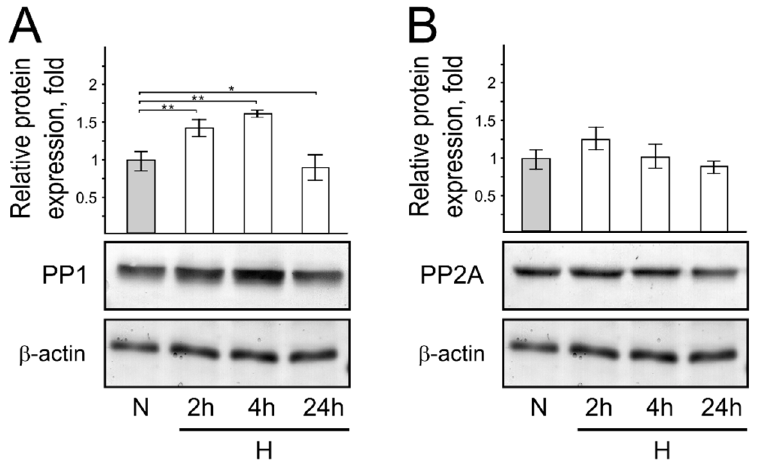
Figure 6. Protein phosphatase PP1 and PP2A protein expression in normoxic and hypoxic HCT116 cells. Western blot showing PP1 ( A ) and PP2A ( B ) protein expression levels in normoxic and hypoxic cells. Bar plot represents the quantification of endogenous protein expression of 3 independent experiments when protein expression in cells grown under normal oxygen conditions is taken as 1. Error bars represent the amount of spread between the extremes of the data, ** p < 0.05; * p < 0.01. N—cells cultivated under normal conditions; H—cells cultivated under hypoxic conditions for indicated time (2 h, 4 h, and 24 h).